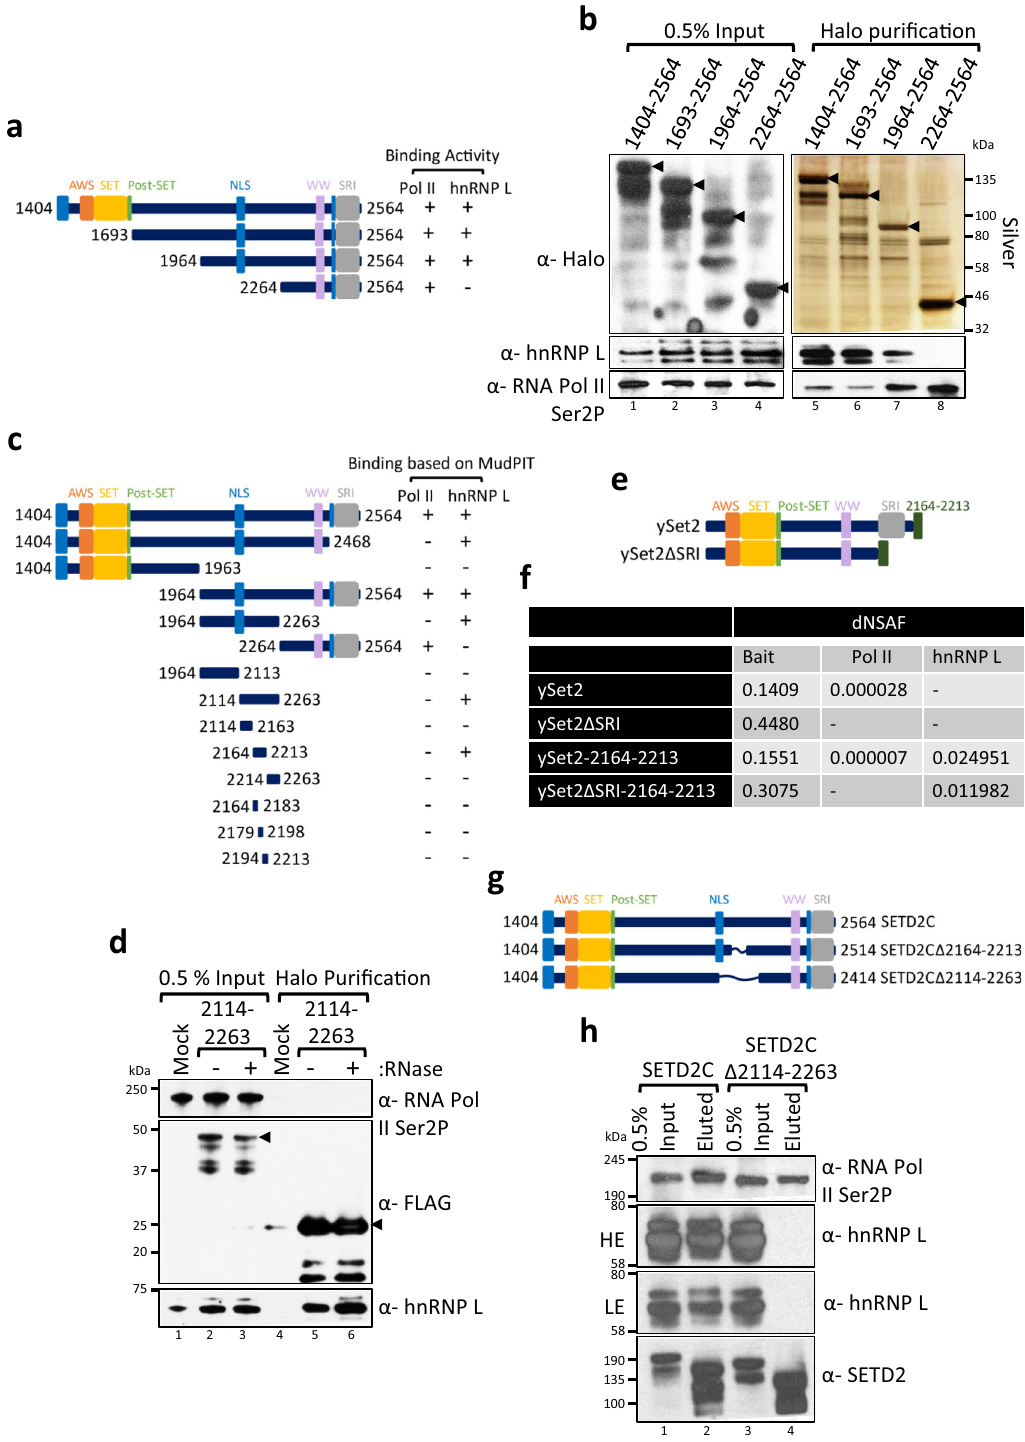
Fig. 3 Domain mapping experiment reveals a novel SETD2-hnRNP interaction (SHI) domain in SETD2. RNase treatment was not performed for these experiments. a , c , e , g Cartoon illustrating the SETD2 and ySet2 constructs along with the known domains that were used in af fi nity-puri fi cations. b , d , h Halo puri fi cation was performed from extracts of 293T cells expressing Halo- or Halo-FLAG-tagged proteins. Input and eluted samples were resolved on gel followed by silver staining or western blotting. The expected band for the target proteins are depicted by arrows. HE high exposure, LE low exposure, * non- speci fi c. The experiments were repeated at least two times all yielding similar results. f Table showing the dNSAFs of the listed proteins post